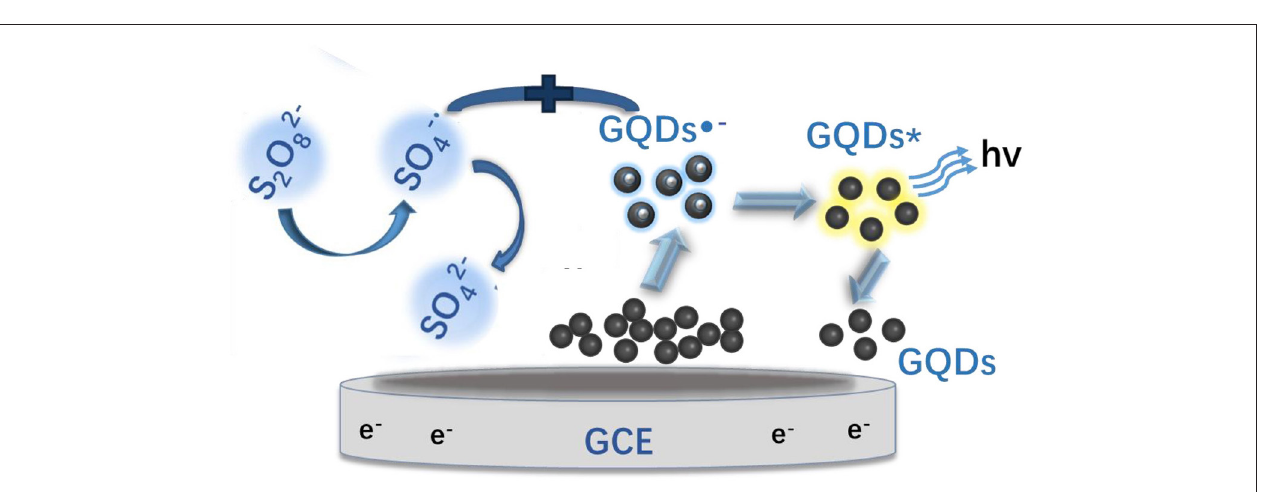
FIGURE 4 | ECL mechanism of the GQD sensor. GQDs*: excited-state GQDs; h + : positive holes; GCE, glassy carbon electrode.